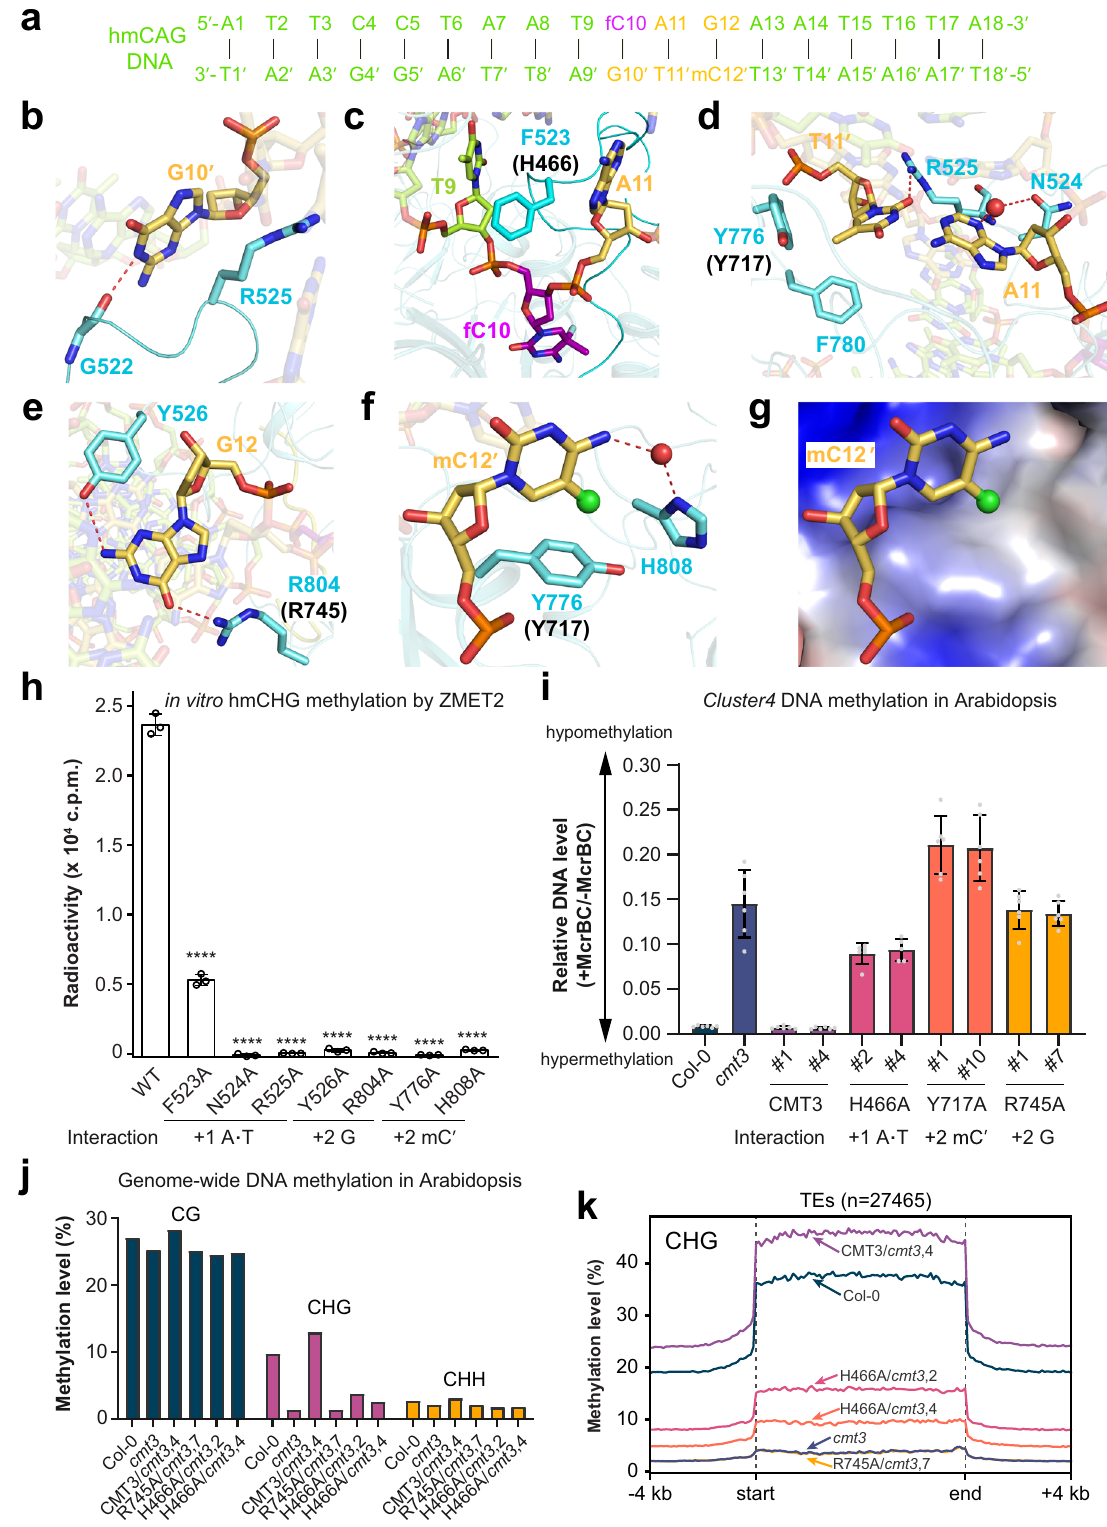
T3-A24, except for T11-G13) was traced for the one spanning the base pairs (Cyt5·Gua5 ′ -Thy15·Ade15 ′ ; Fig. 2a and Supplementary BAH and MTase domains (expanded views in Fig. 1d). Fig. 3a), involving two loops from the catalytic core, namely catalytic-loop (residues 514-537) and allosteric loop (residues 612-657). The catalytic-loop penetrates the DNA minor groove while the allosteric loop traverses across the DNA double strands Sequence-speci fi c ZMET2-hmCAG interaction . The interaction (Supplementary Fig. 3b-d). Furthermore, two loops from the between ZMET2 and the 18-mer hmCAG DNA spans over 11 NATURE COMMUNICATIONS| (2022) 13:3877